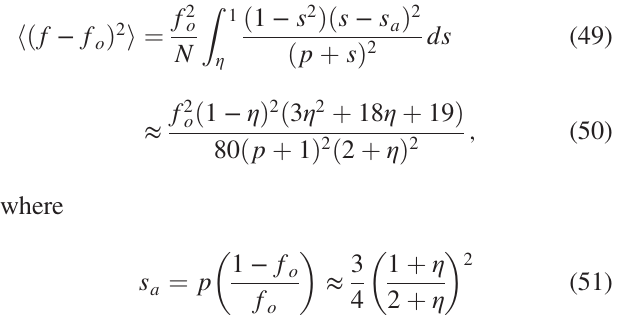
FIG. 6. Behavior of the ratio ε as calculated using Eq. (52) n; rms f with C as calculated using Eq. (54) for parameters typical of o o thermal emission in Table III. The (red) solid line labeled “ Leading Order ” refers to the ratio of Eq. (53) with Eq. (54), p ffiffiffiffiffiffiffiffiffiffiffiffiffiffiffiffiffiffiffiffiffiffiffiffiffiffiffiffiffiffiffi 3 η 2 þ 18 η þ 19 or ½ð 1 − η Þ 3 (cid:2) .